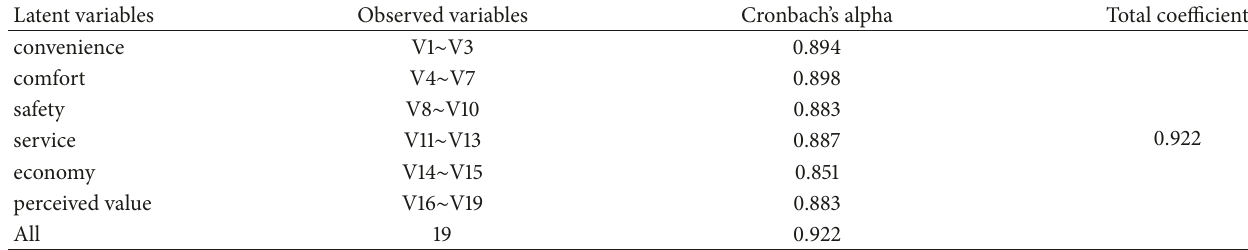
Table 4: Cronbach’s alpha scores of the questionnaire.